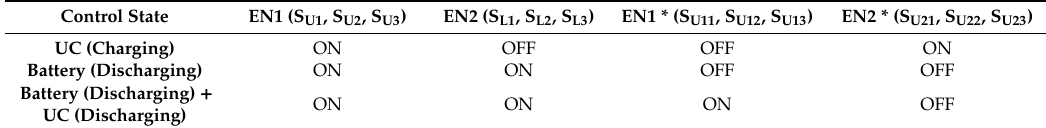
Table 4. Latch and switch enable States for modes-1,2, and 3.